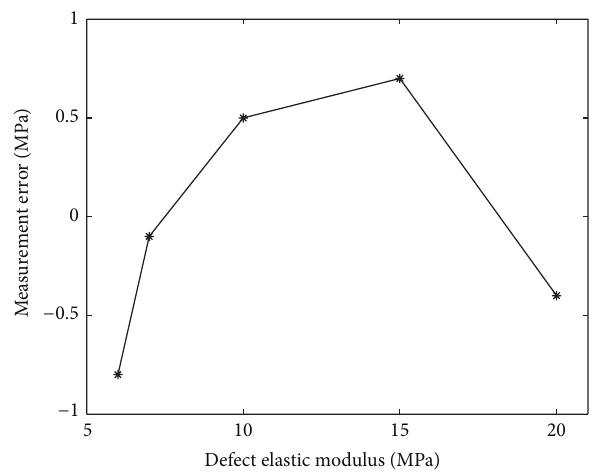
Figure 4: Measurement errors for various elastic moduli of the